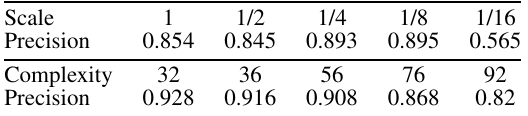
Table 2. Detection performance with respect to different scale of images and different complexities of fac¸ade